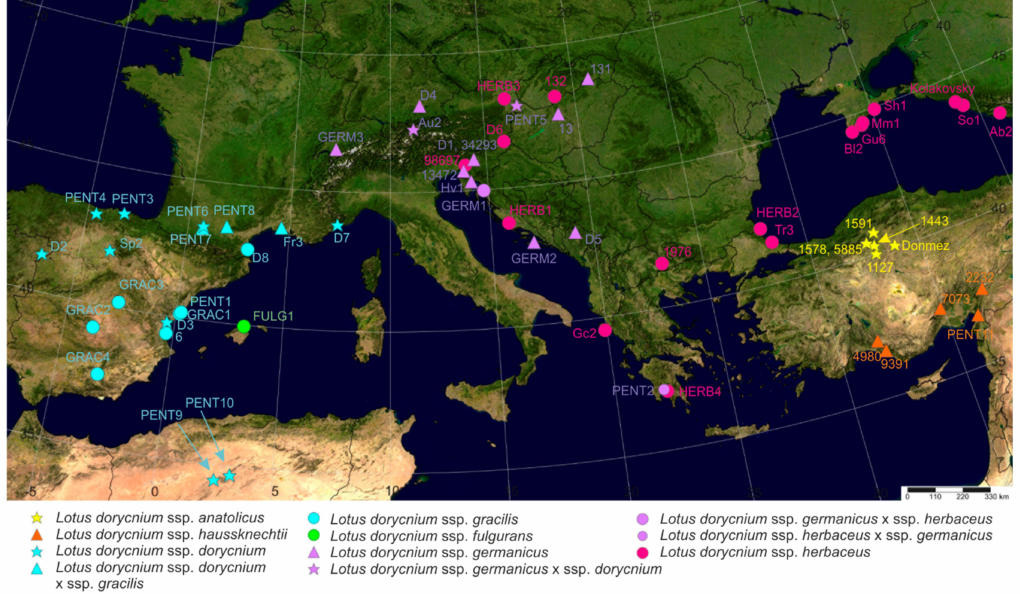
Figure 8. Geographical localities of specimens of the Lotus dorycnium complex studied here using molecular